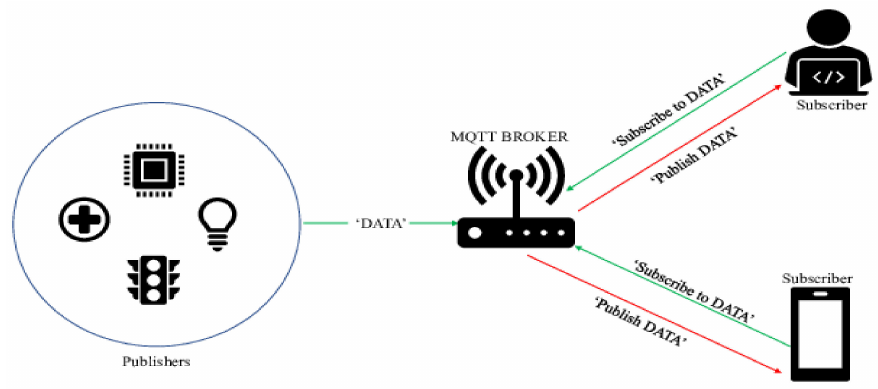
Figure 1. Topology of the MQTT protocol [10].